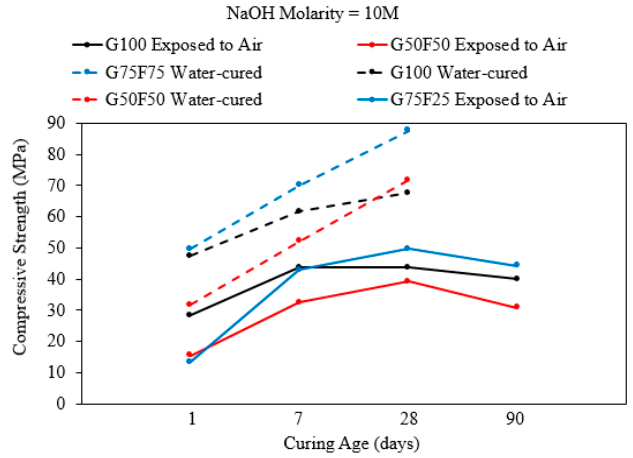
Figure 7. Compressive strength of mortar cured in open and closed systems for up to 90 days with an AASF binder and NaOH molarity = 10 M. Air-cured mortar decreased in strength by the age of 90 days [2].